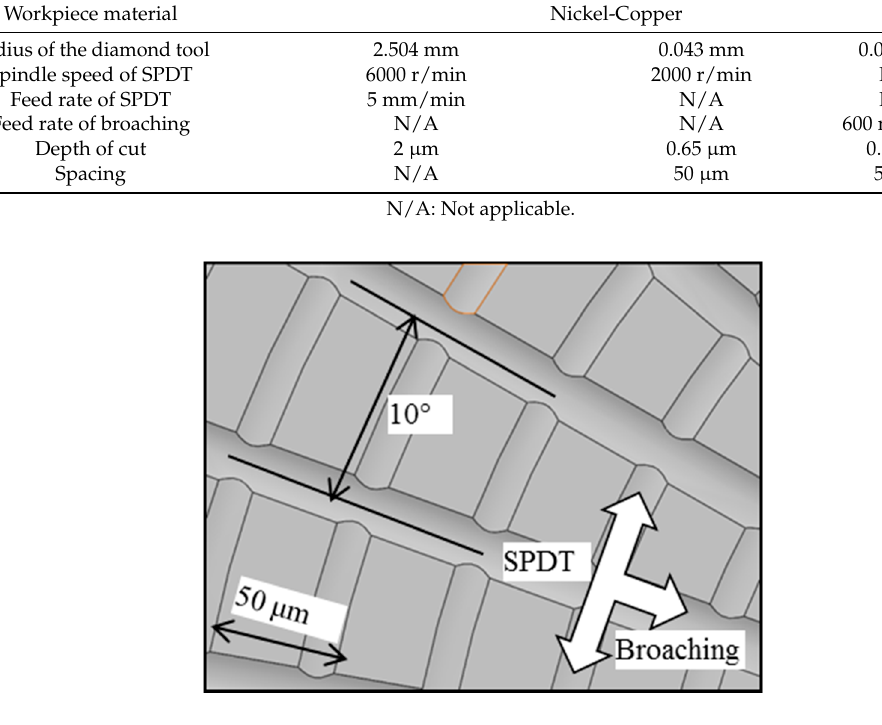
Figure 7. Enlarged top view of the process chain model for machining polar microstructure.